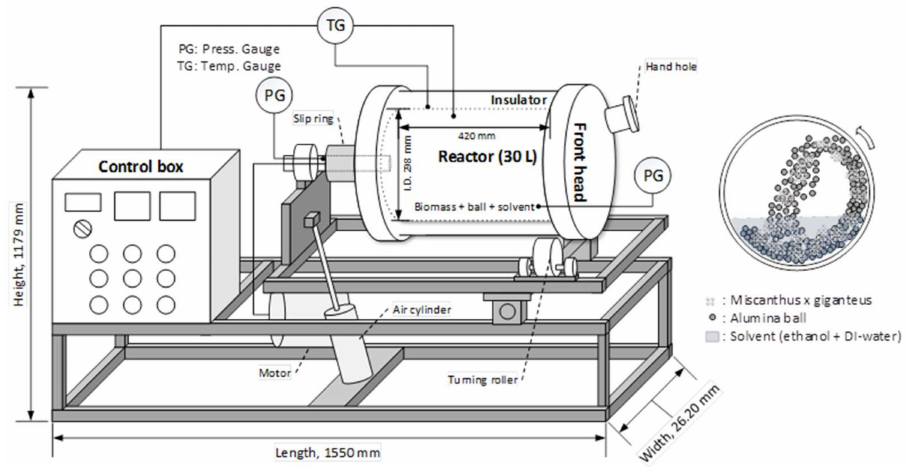
Figure 6. Schematic diagram of bench scale ball milling pretreatment reactor setup. PG (pressure gauge); TG (temperature gauge); DI (deionized)